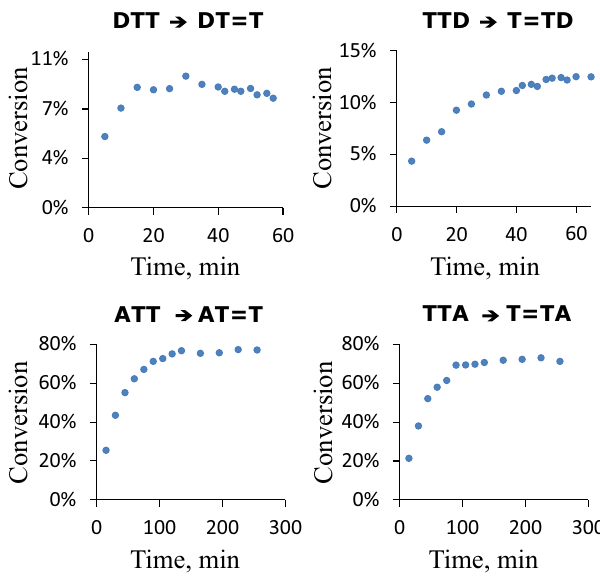
Fig. 3 Continuous UV-irradiation experiments of undamaged DNA trinucleotides in the UV-B spectral range. Samples were exposed to continuous UV-B fl ux (1.95 mW cm − 2 ) to yield photostationary equilibria of T = T dimer formation and self-repair. Analysis of photoproducts was performed by HPLC and % of conversion of undamaged DNA trimers into the damaged trinucleotides was calculated by integration of the respective peak areas (see the SI and the Methods section for more